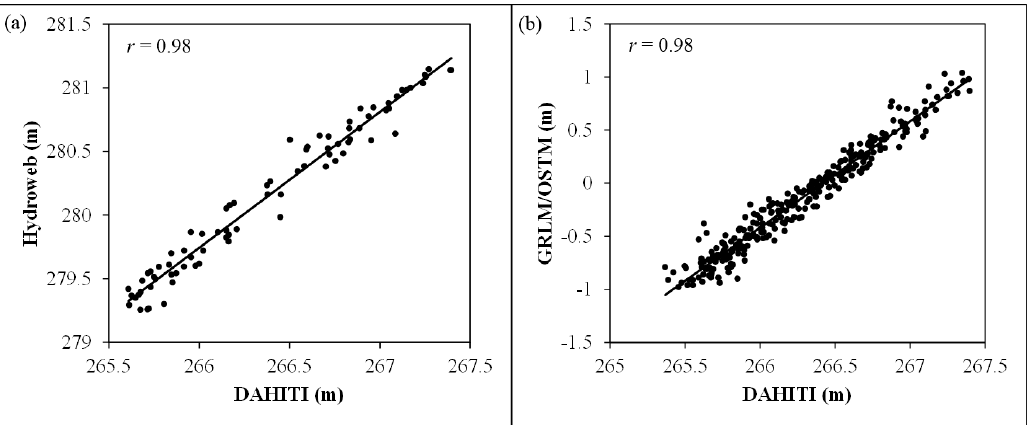
Figure 7. Scatterplots of the water levels retrieved from: Hydroweb ( a ); and GRLM/OSTM ( b ), and the corresponding water levels retrieved from DAHITI.